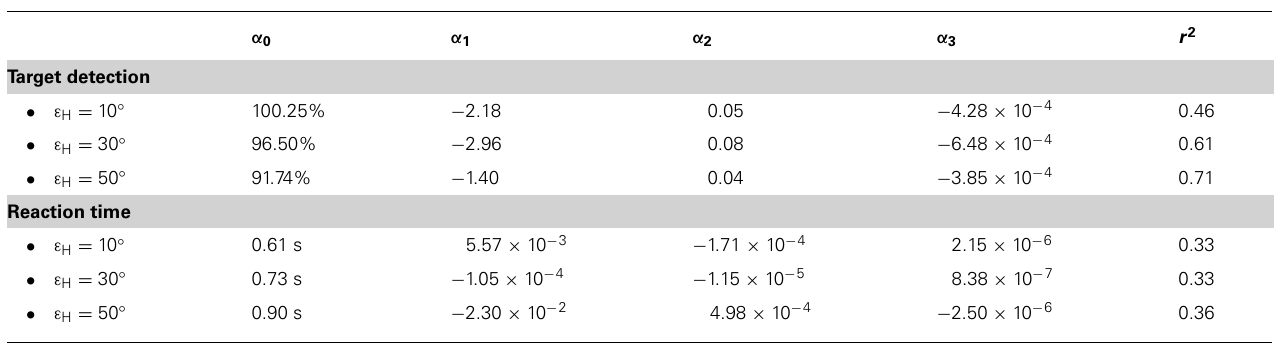
β β β 0 1 2 (years)